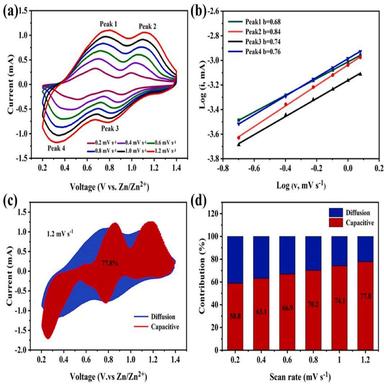
(a) CV curves at various scanning rates of the B–V2O3@C. (b) Relationships between logarithm redox peak current and logarithm scanning rate of B–V2O3@C. (c) Capacitive contribution and diffusion contribution of B–V2O3@C at 1.2 mV s − 1 . (d) Capacitive/diffusion contribution ratios of B–V2O3@C at various scanning rates.